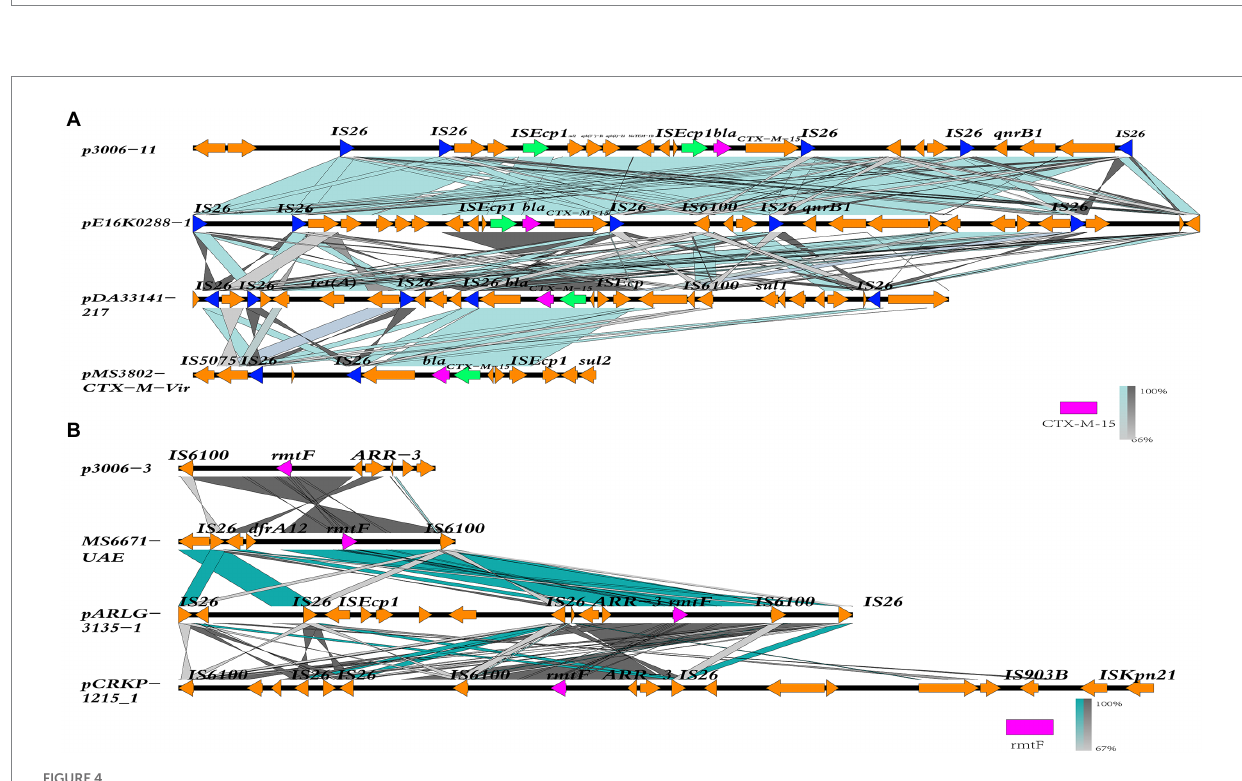
FIGURE 4 Linear comparison of the bla CTX -M-15 and rmtF region. (A) The bla CTX -M-15 region was compared with the regions extracted from pE16K0288- 1(CP052263.1), pDA33141-217(CP029588.1), and pMS3802-CTX-M-Vir(NZ_CP068016.1). (B) The rmtF region was compared with the regions extracted from MS6671-UAE(LN824138.1), pARLG-3,135-1(CP033947.1), and